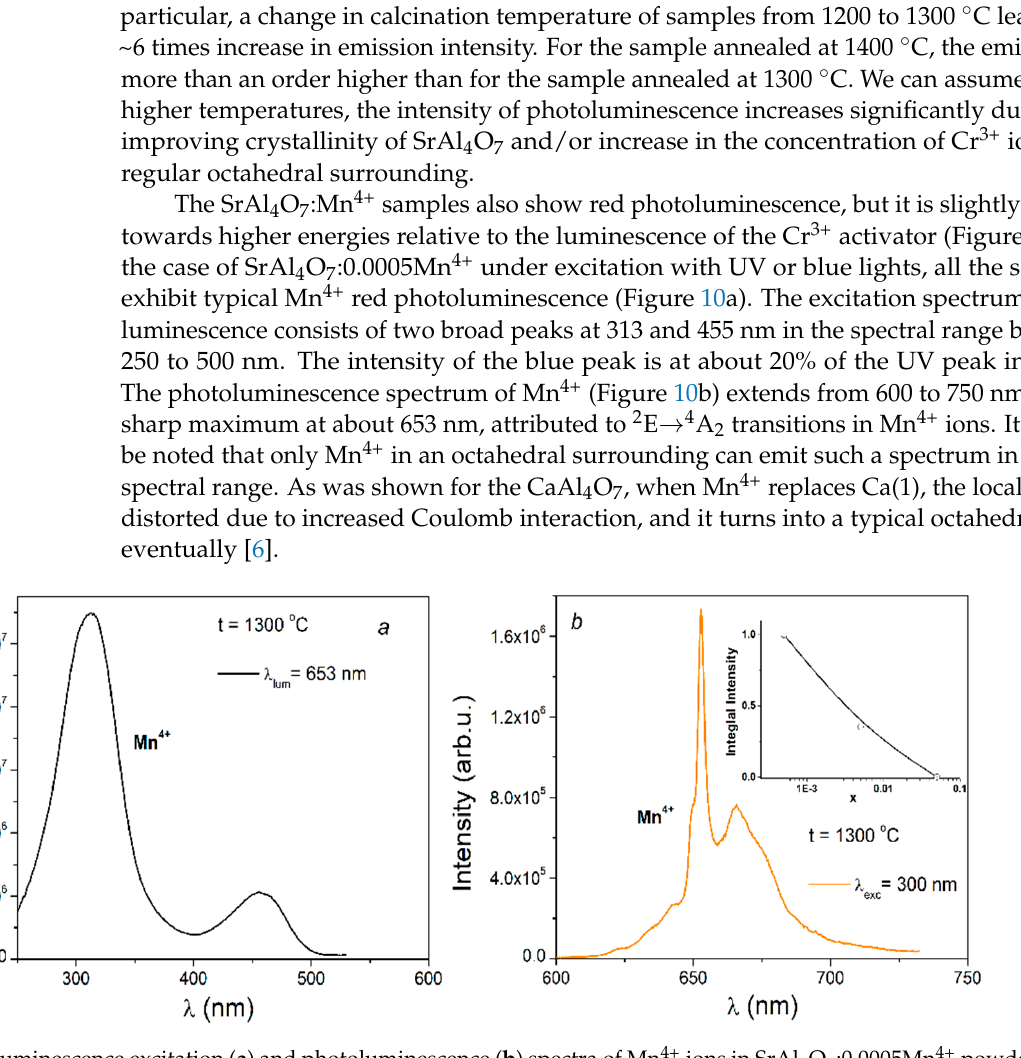
Figure 10. The luminescence excitation ( a ) and photoluminescence ( b ) spectra of Mn 4+ ions in SrAl 4 O 7 :0.0005Mn 4+ powders. The inset of ( b ) presents the concentration dependence of Mn 4+ integral photoluminescence.